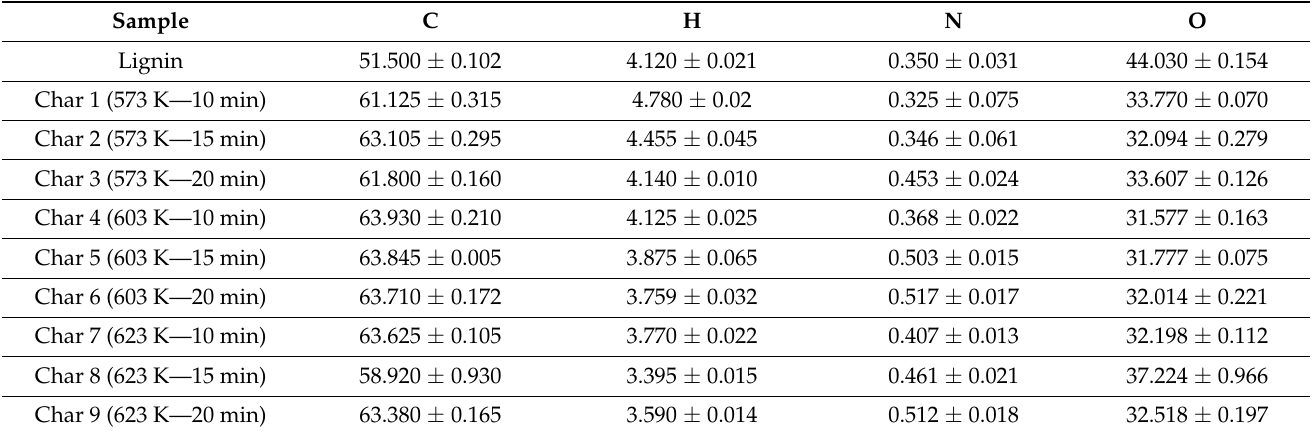
Table 1. Ultimate analysis results of the experimental samples (wt.% dry ash-free).